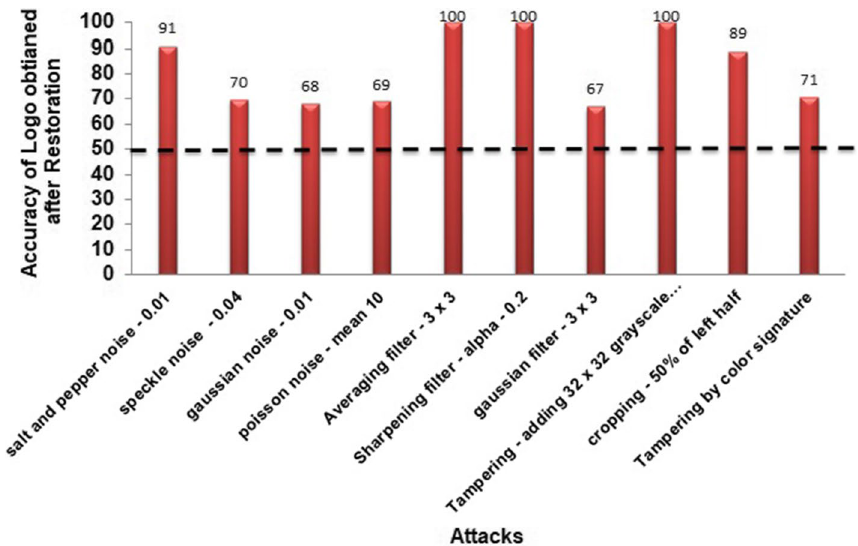
Fig. 13 Attacks vs. accuracy of logo obtained after